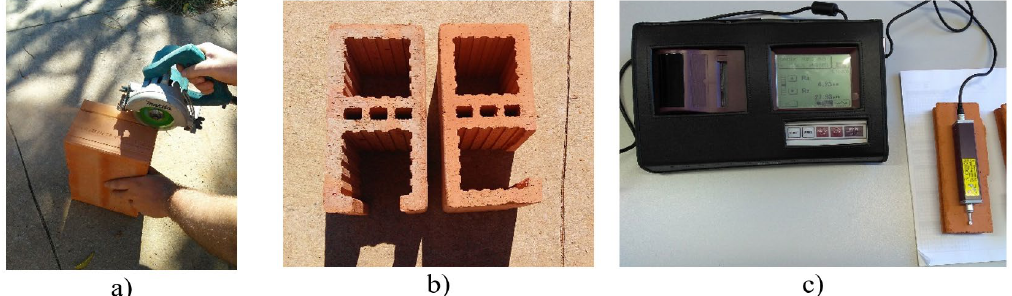
Figure 2. Scheme of roughness